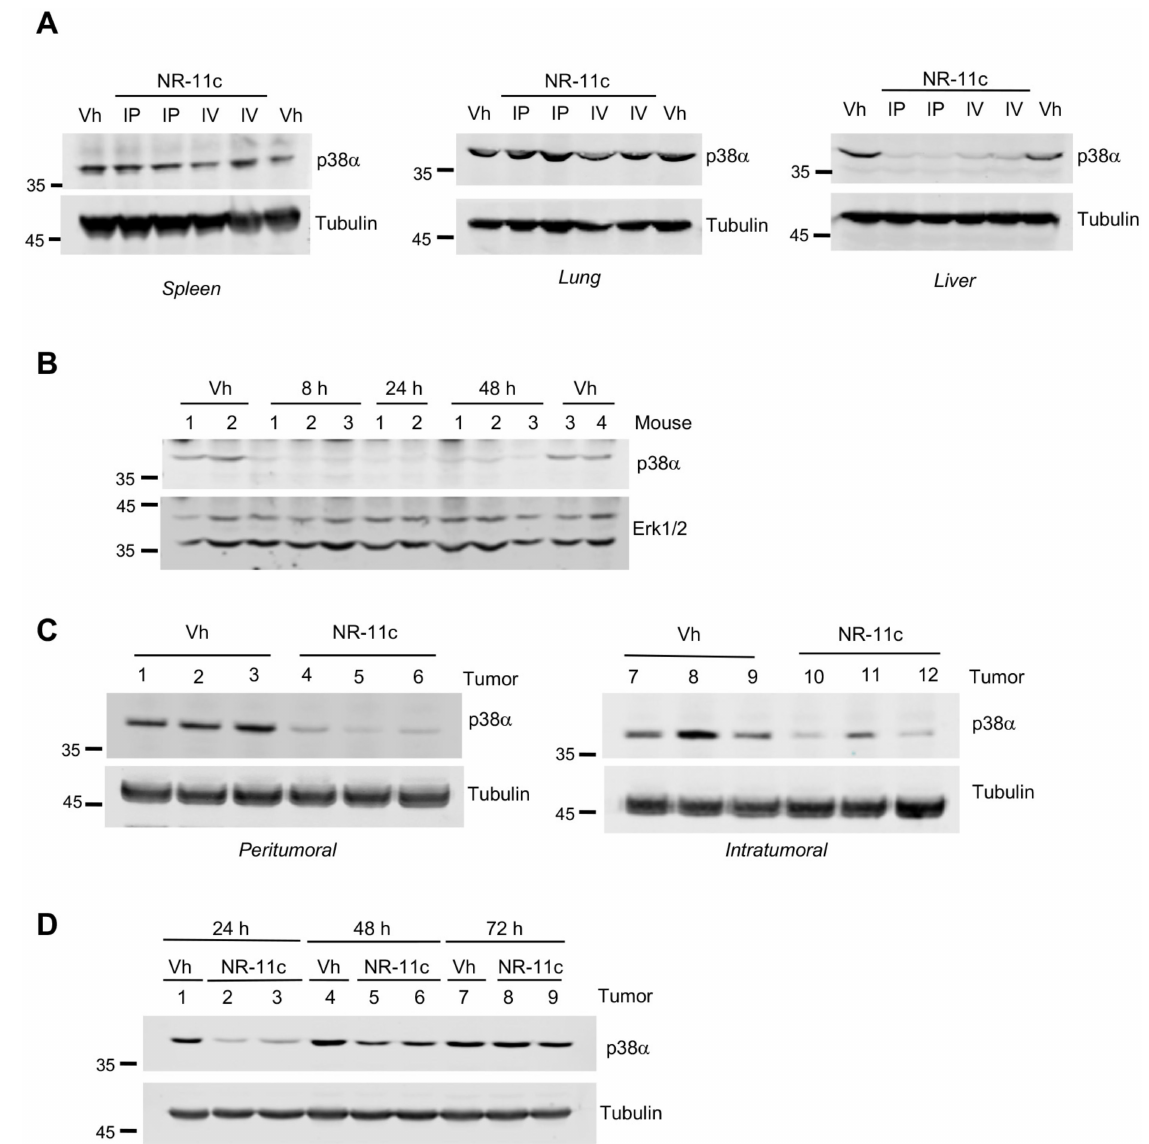
Figure 7. Effect of NR-11c in mice. ( A ) C57BL/6J mice were administered intraperitoneal (IP) or intravenously (IV) with NR-11c at 15 mg/kg dissolved in PBS with 50% cyclodextrin or with vehicle (Vh). Mice treated via IP received two doses in 24 h, while mice treated via IV received only one dose. After 24 h, the indicated tissues were obtained, and p38 α protein levels were analyzed by immunoblotting. Tubulin was used as a loading control. ( B ) C57BL/6J mice were administered IP with NR-11c at 15 mg/kg or with Vh, and livers were collected at the indicated times for immunoblotting analysis. Erk1/2 was used as a loading control. ( C ) MDA-MB-231 cells implanted in the mammary fat pad of SCID/NOD mice and allowed to grow up to 100–150 mm 3 (4–5 weeks). NR-11c or Vh were administered via the indicated routes. After 24 h, mammary tumors were collected and p38 α protein levels were analyzed by immunoblotting. ( D ) Mice with tumors formed by MDA-MB-231 cells as in ( D ), were injected peritumorally with NR-11c or Vh as control, and at the indicated times, tumors were collected and p38 α protein levels were analyzed by immunoblotting. All treatments were done with at least 2 mice with similar results obtained in each case. The uncropped blots are shown in Supplementary Materials File